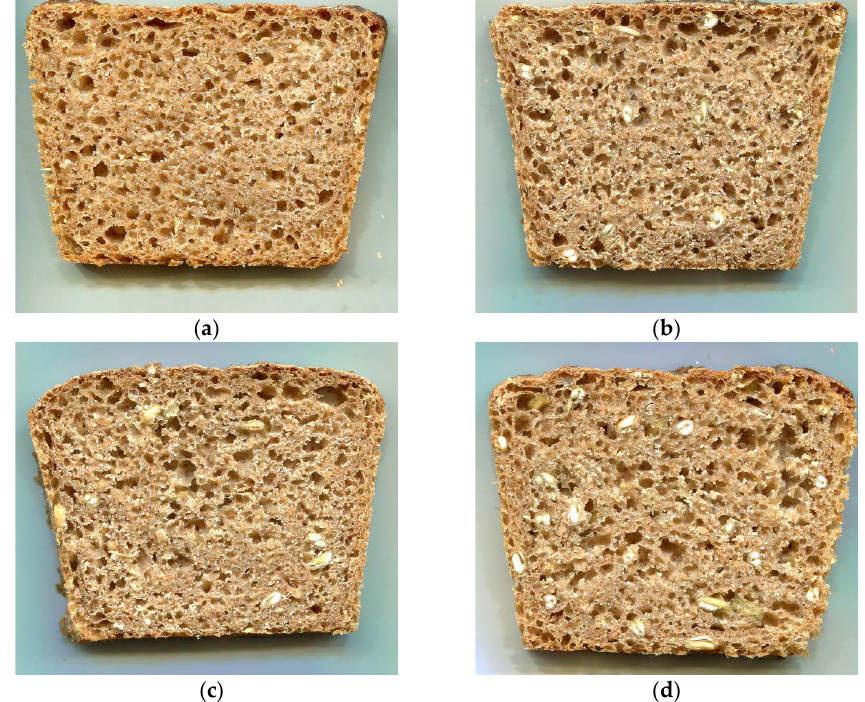
Figure 2. Wholemeal bakery products made from spelt flour: ( a ) Control bread; ( b ) Spelt bread enriched with green grain of spelt added in proportion of 4%; ( c ) Spelt bread enriched with green grain of spelt added in proportion of 8%; ( d ) Spelt bread enriched with green grain of spelt added in proportion of 12%.